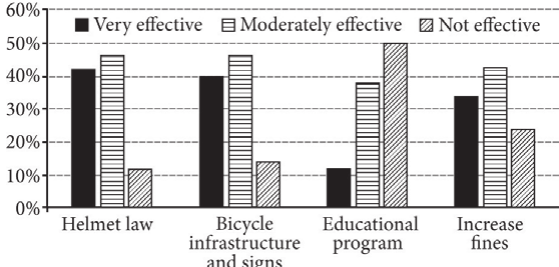
Fig. 2. Recommendation of the university bicyclists to improve the safety of